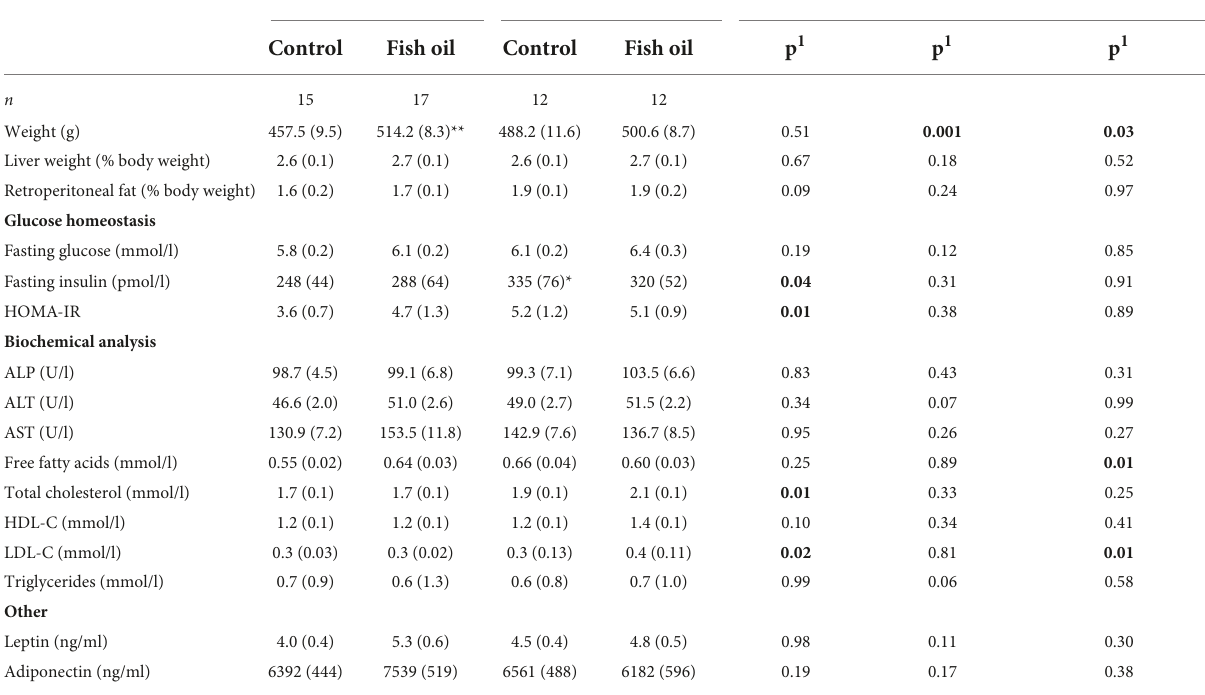
Diet vs. treatment treatment interaction